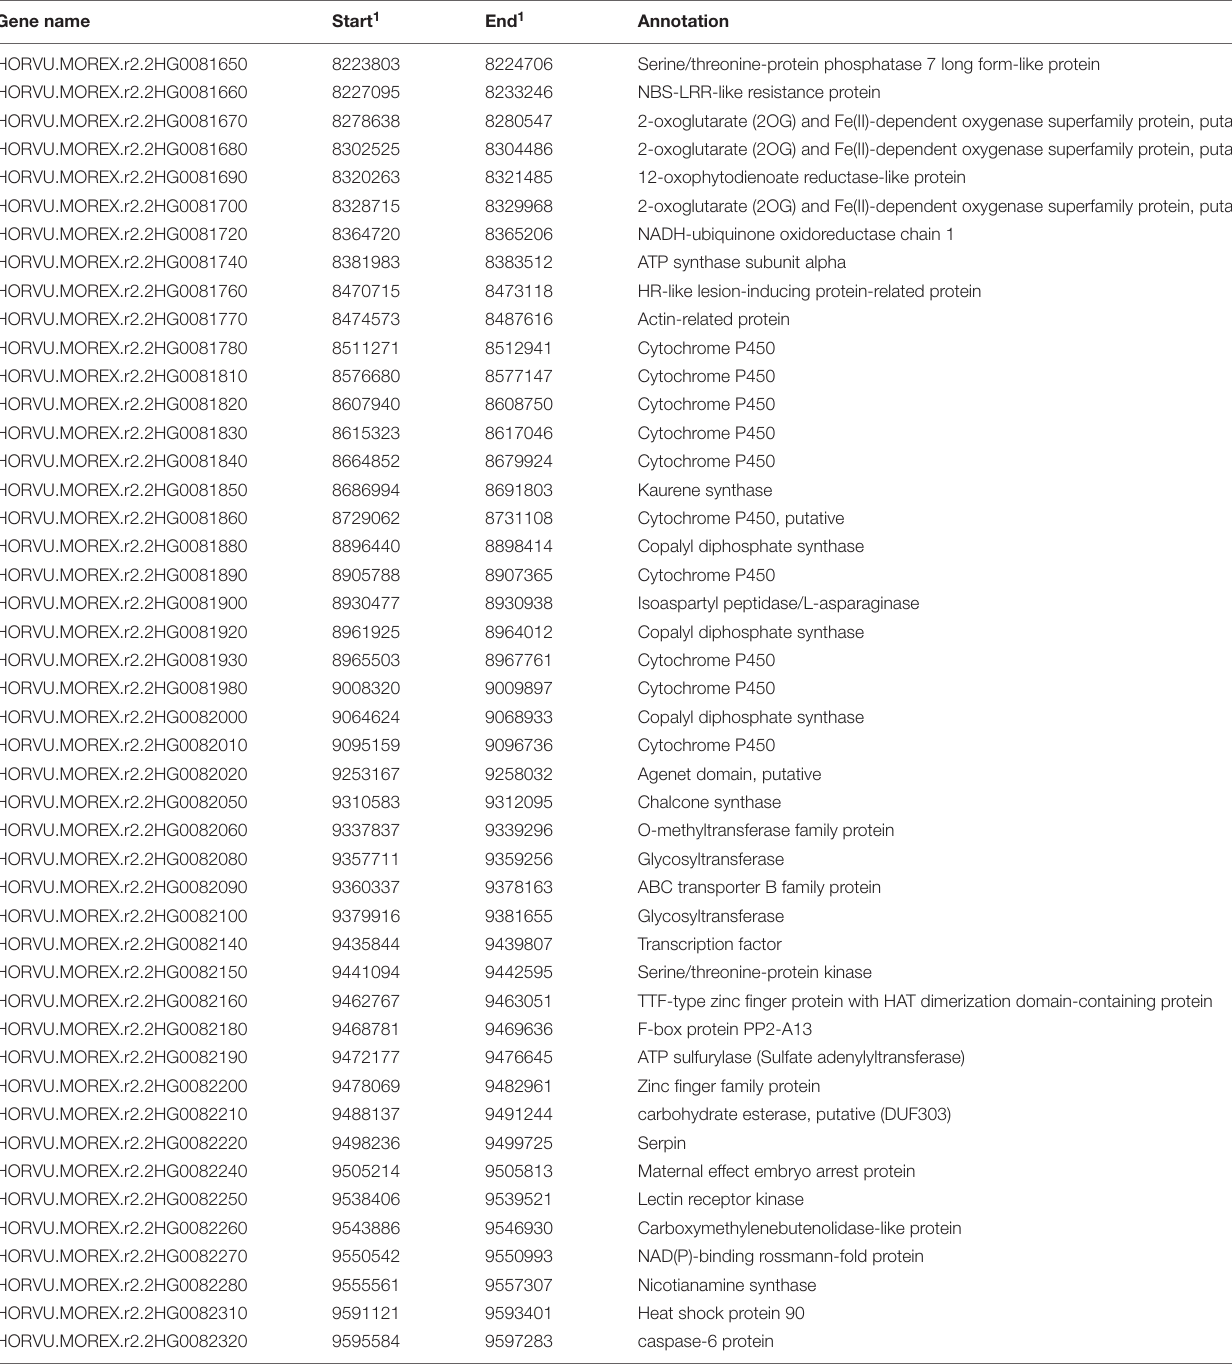
TABLE 3 | High confidence (HC) genes based on automated annotation of barley reference